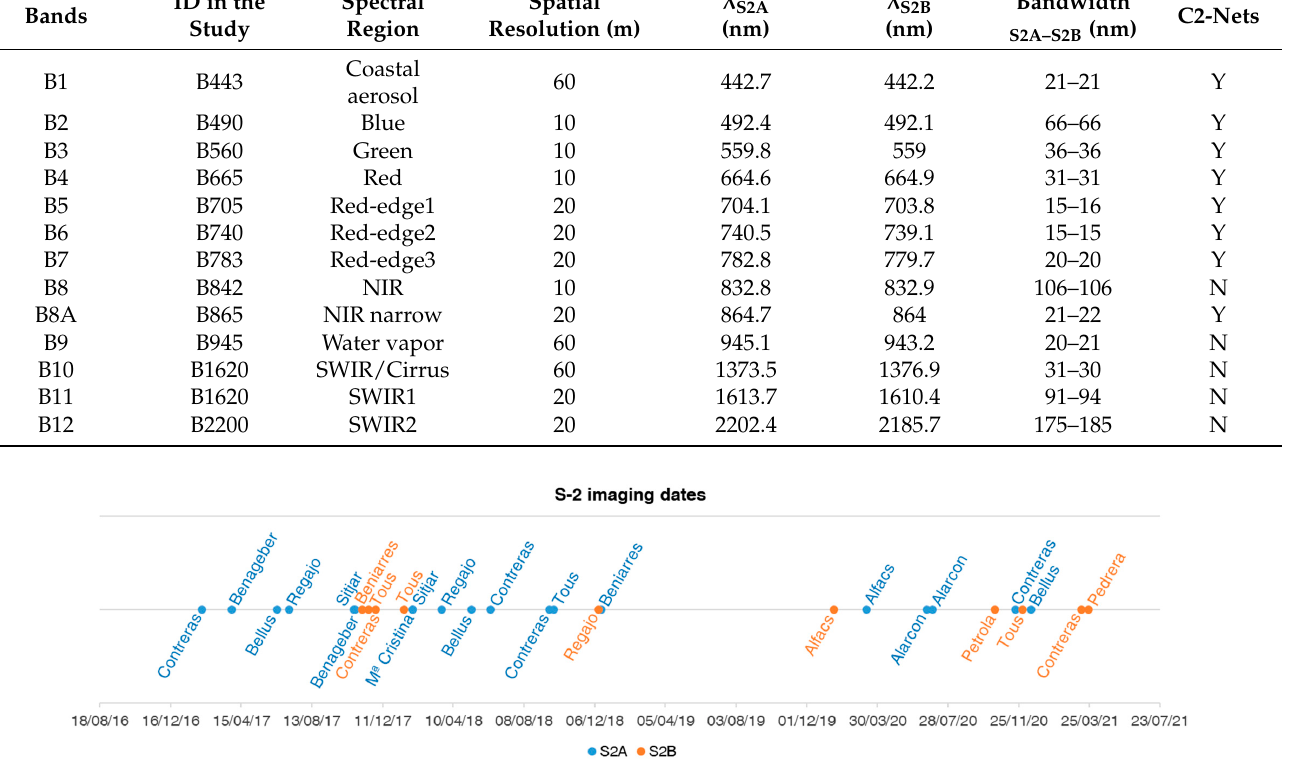
Figure 2. Temporal line of cloud-free S2 A/B images matching field measurements by study area. Table 3. S2A and S2B spectral bands, central wavelength ( λ ), spatial resolution, and application. Data from Copernicus Sentinel-2 MSI user guide [22]. The field ‘C2-Nets’ indicates the spectral bands outputted by C2-Nets (Y = yes, N = no).